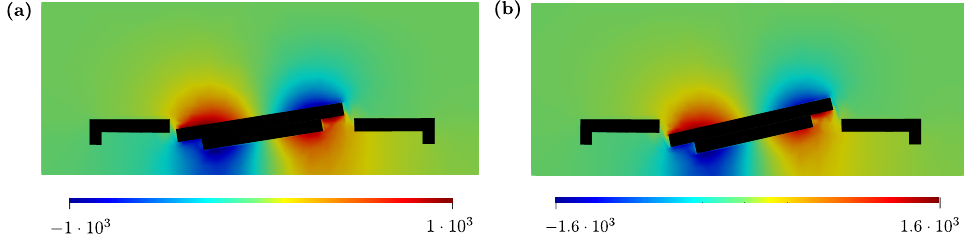
Figure 12. Pressure field [ µ Pa] for Micromirror 2 in a section generated by the e 2 − e 3 plane passing through the centre of the box at t = T p for α = 10.00 ◦ ( a ), and α = 14.30 ◦ ( b ).